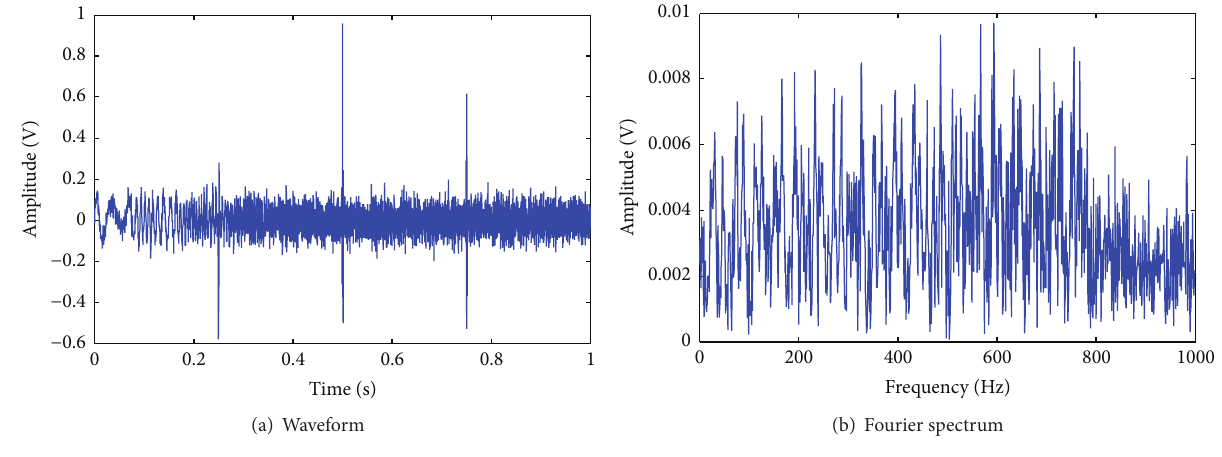
Figure 1: Simulated